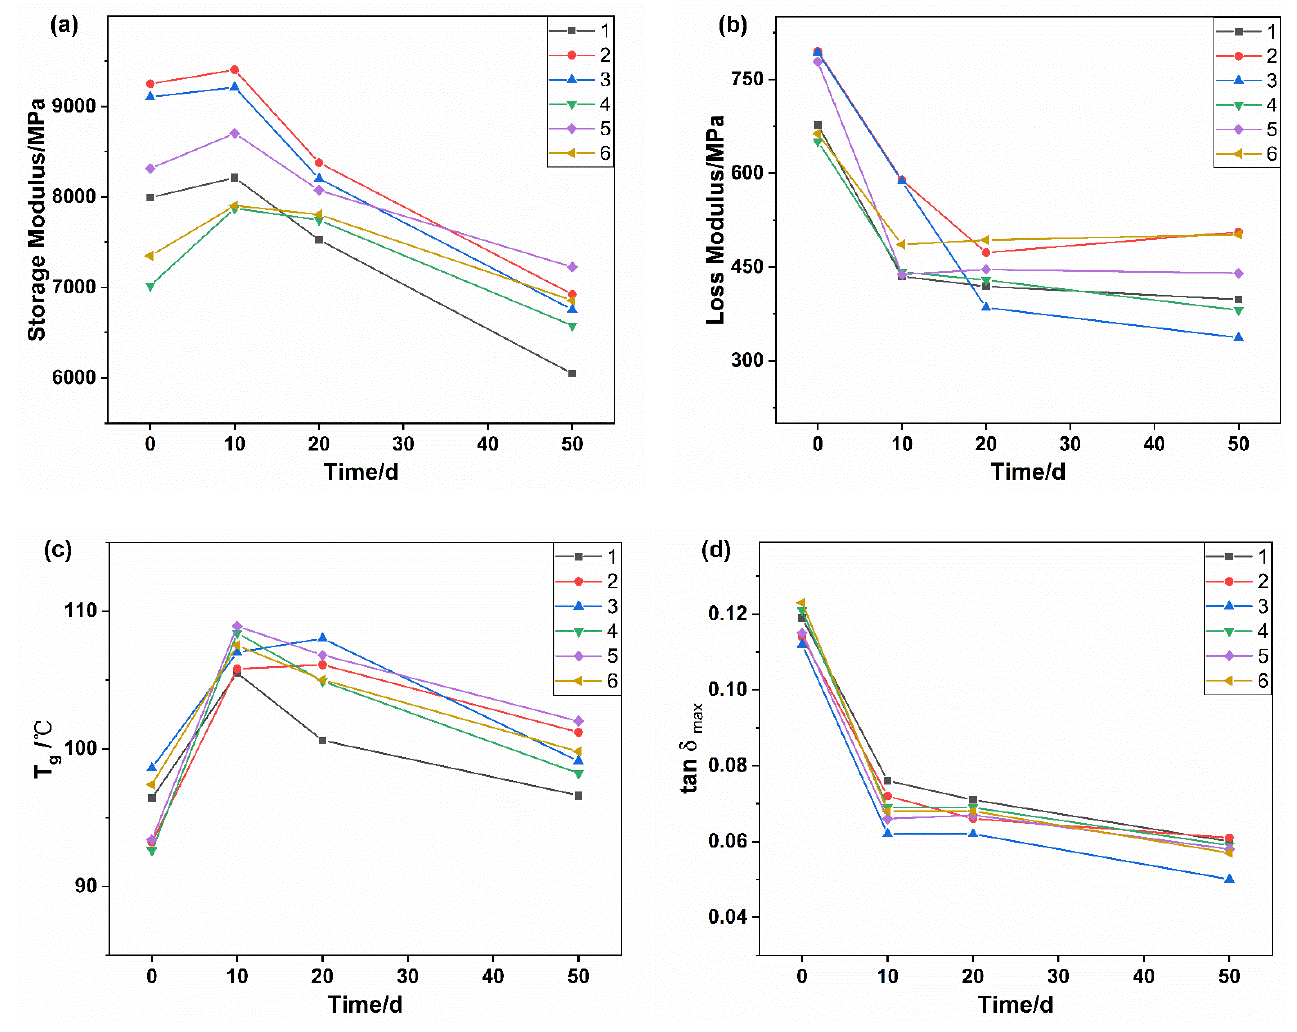
Figure 11. Storage modulus ( a ), loss modulus ( b ), T g ( c ), and tan δ max ( d ) of the PA56T/GF samples for different aging time at 150 °C.